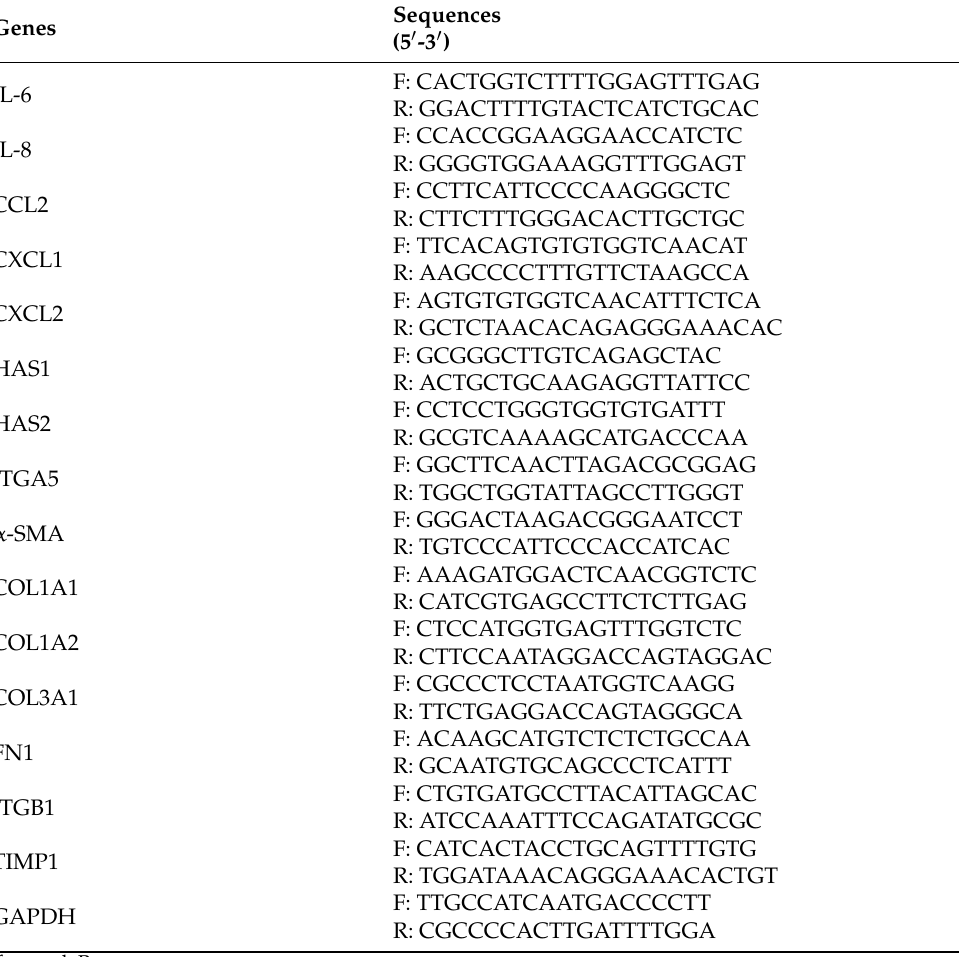
Table 2. Primer Sequences of